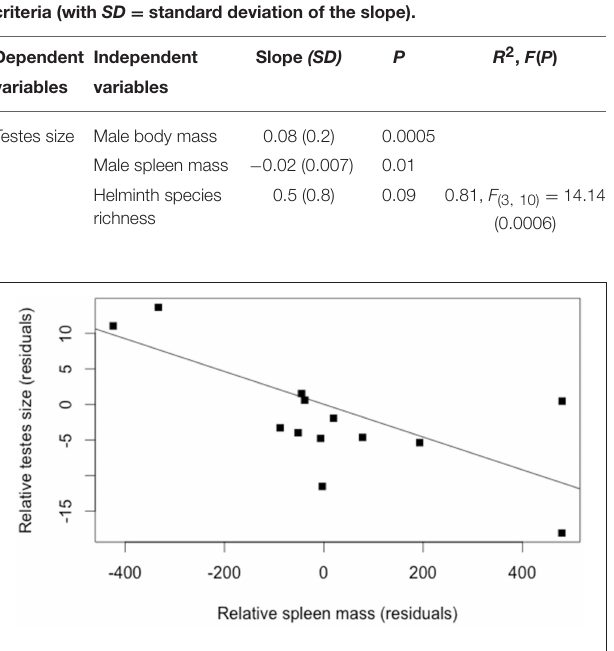
FIGURE 4 | Partial regression between the residuals of contrasts in testes size and the residuals in spleen size in males (controlling for the contrasts in male body mass and parasite species richness, using the model of Table 4); ( R 2 = 0.49 , P = 0 .005).